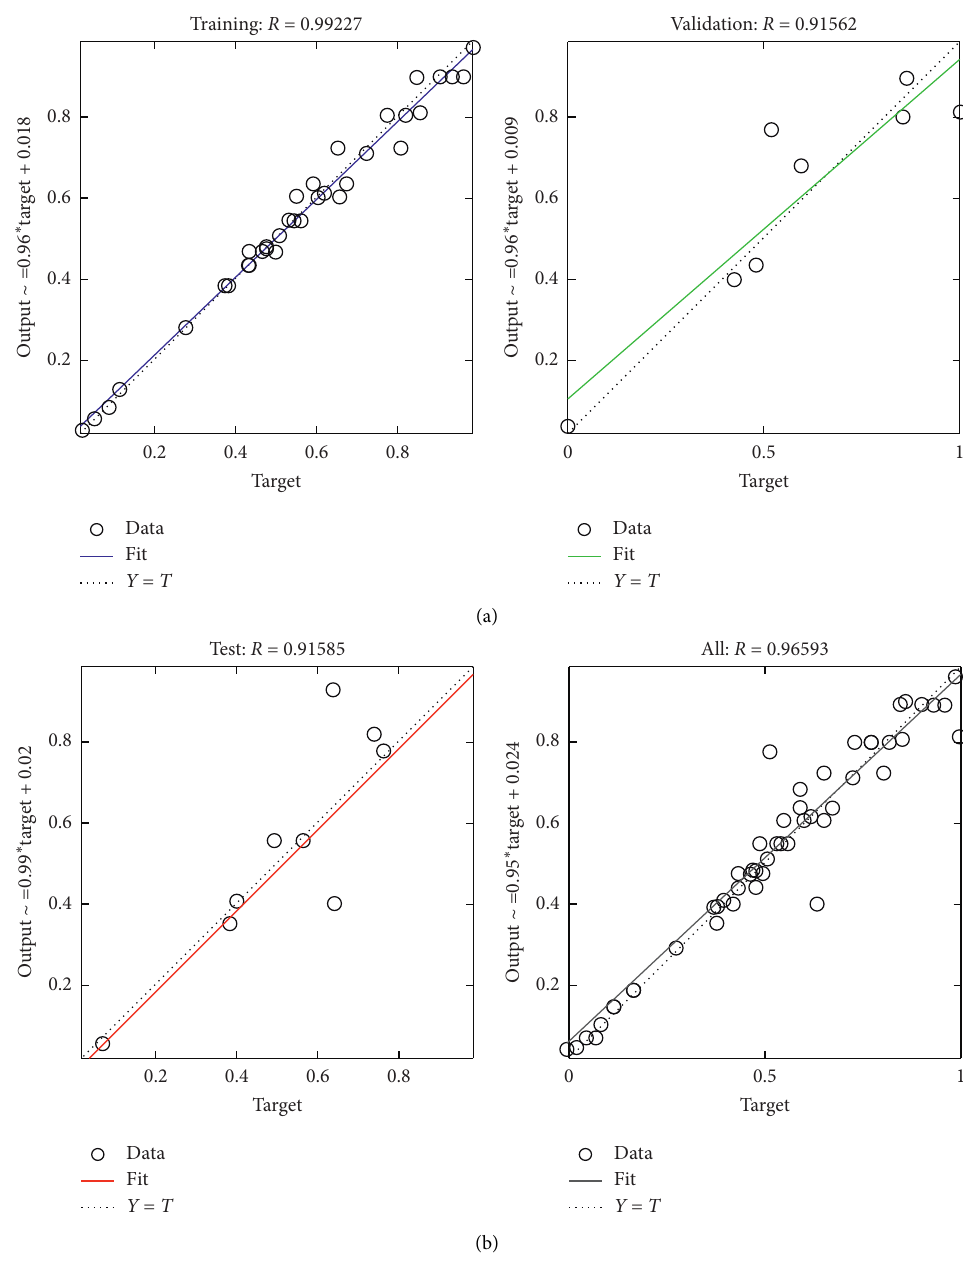
Figure 5: Simulation results of